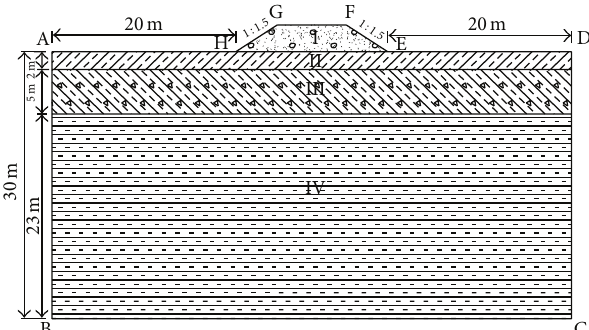
Figure 3: The computational region. Zone I is gravel backfill, zone II is sub-clay, zone III is crushed rock and sub-clay, and zone IV is argillaceous